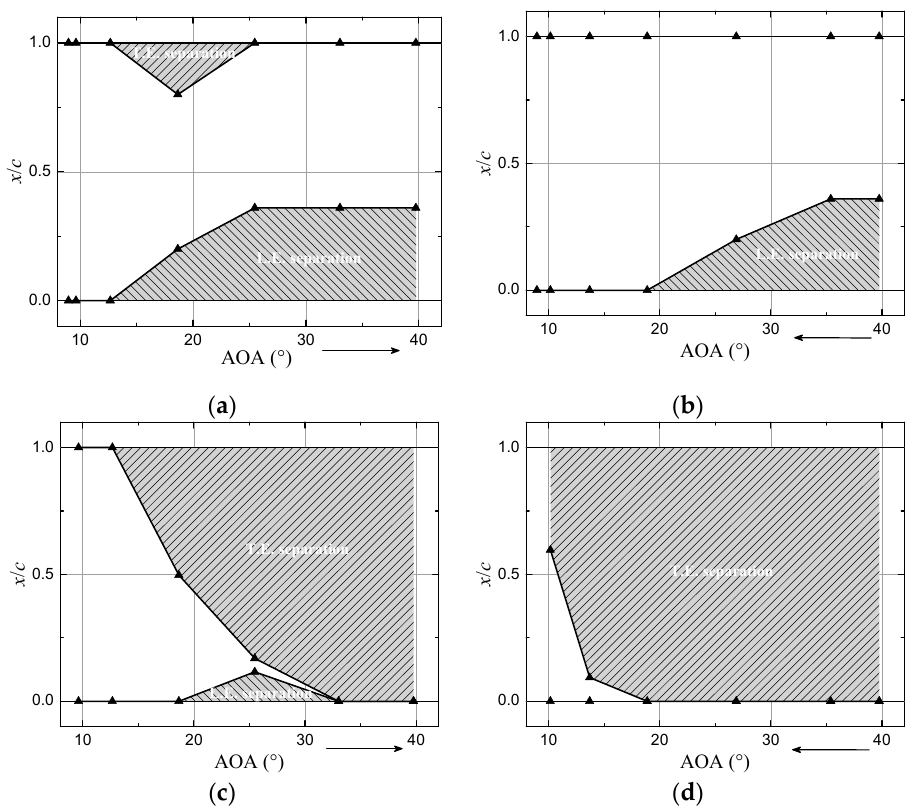
Figure 17. Comparison of flow separation and reattachment between the blade section and airfoil. r / R = 30%, V w = 13 m/s, and ϕ y = 30°. ( a ) 3D blade flow with increasing AOA; ( b ) 3D blade flow with decreasing AOA; ( c ) 2D airfoil flow with increasing AOA; ( d ) 2D airfoil flow with decreasing AOA.